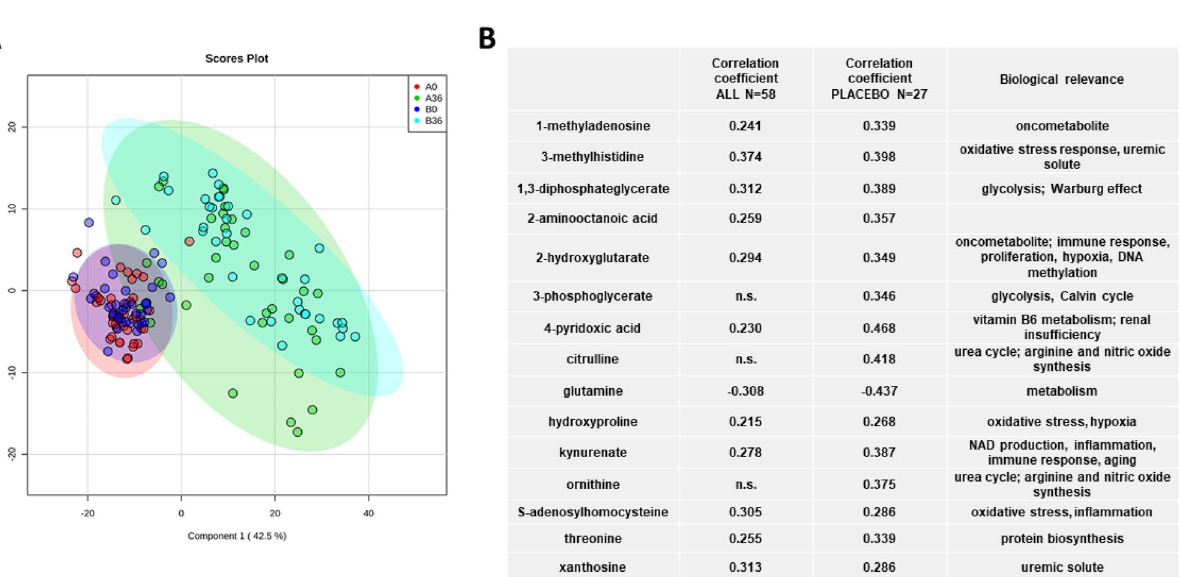
Figure 2. ( A ) Pearson correlation coefficients and ( B ) pathway enrichment analysis of plasma metabolites that significantly correlated with HtTKV at baseline in pediatric ADPKD patients (N = 78, after adjustment for age, gender and race).